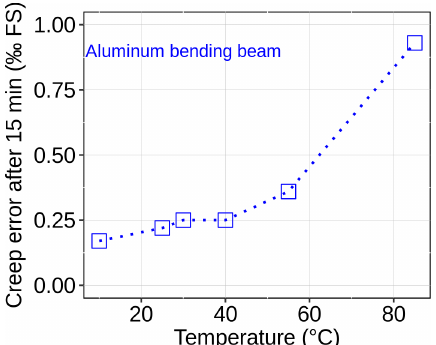
Figure 6. Creep error after 15min of aluminum bending beams with attached Ni 90 Cr 10 − C thin-film SGs, which is plotted versus temperature. The SGs are based on two different carrier substrates: polyimide type A (blue) and type B (red). Every marker symbol represents a sensor specimen; the dotted lines connect the average values (not shown